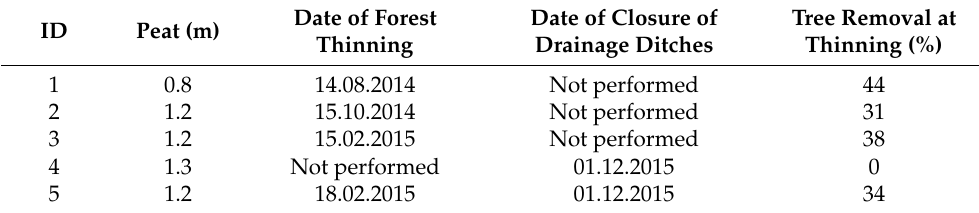
Table 1. Characteristics of the study